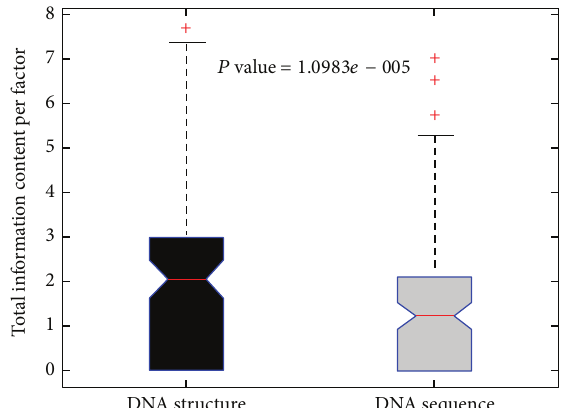
Figure 2: Total information content per factor in structure versus sequence.